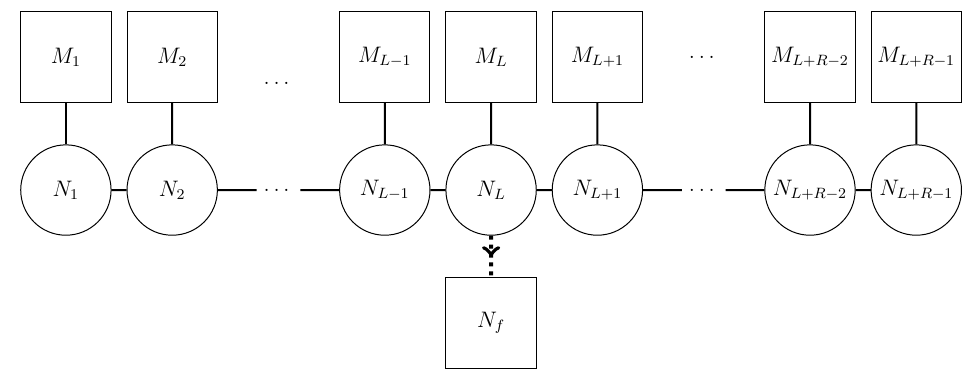
Figure 8 . Quiver diagram for a generic gauged SMM from the brane